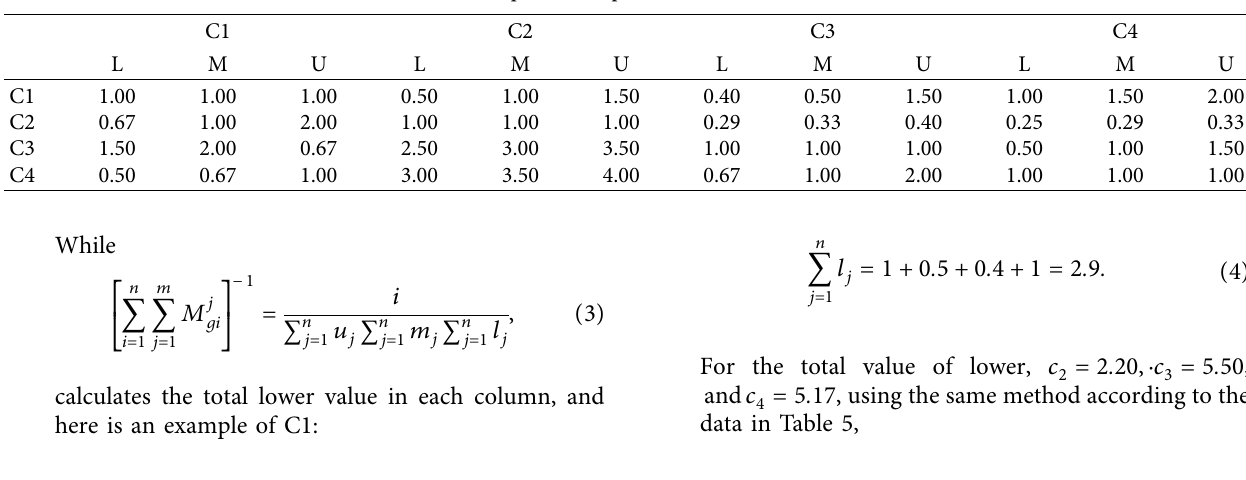
Table 5: Determine the comparison of paired matrices between criteria with